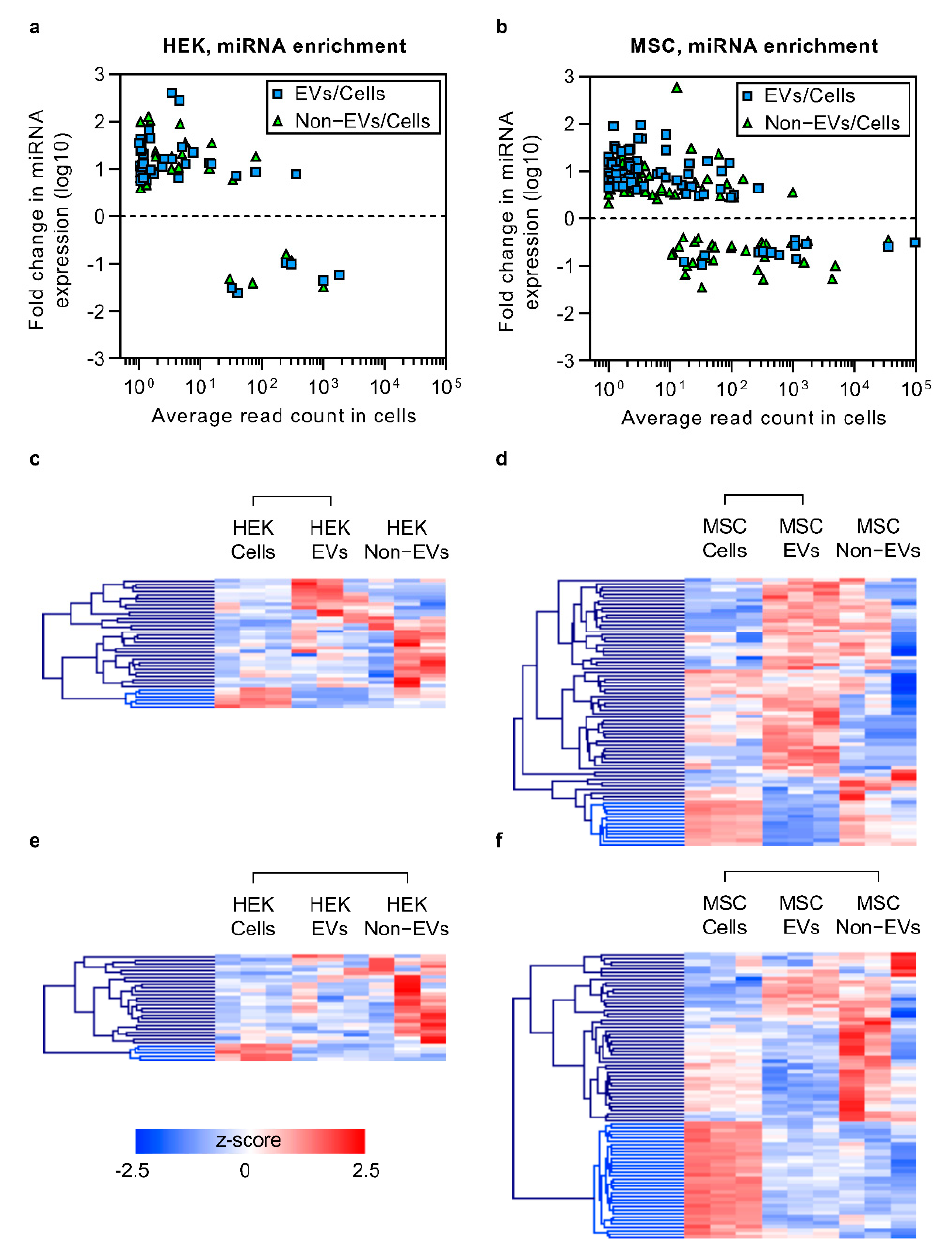
Figure 4. The enrichment pattern of secretory miRNAs as compared to source cells. ( a , b ) miRNA relative enrichment analysis revealed that those miRNAs that were enriched in EVs and Non-EVs had a low average read count in cells. This is true in both HEK as well as MSC samples. ( c – f ) Heat maps of hierarchical clustering analysis further suggested that certain miRNAs are restricted from secretion, as miRNAs enriched in cells were reduced in both the EV and Non-EV fractions. Also, the enrichment of miRNAs in EVs was generally not mirrored in the Non-EV fraction. The connecting lines in c-f denote pairwise sample comparisons.